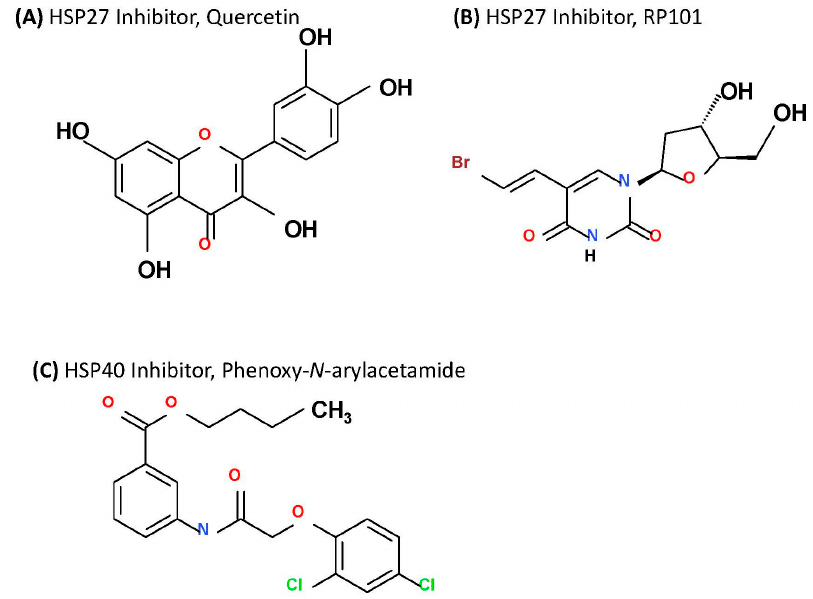
Figure 7. Inhibitors of HSP27 and HSP40. Structures of flavonoid based HSP27 inhibitor quercetin ( A ) and nucleoside RP101 ( B ) compounds are shown. Structure of the most potent HSP40 inhibitor, phenoxy- N -arylacetamide derivative in shown in ( C ).